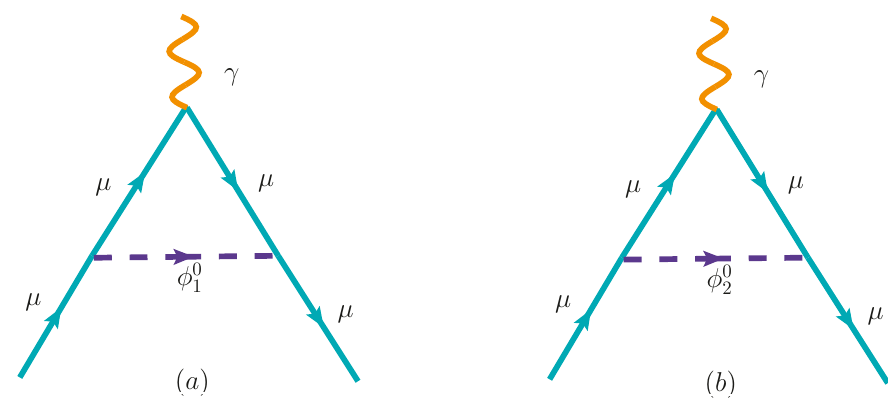
Figure 5 . Feynman diagrams for the interaction of neutral CP-odd scalars (cid:30) 0